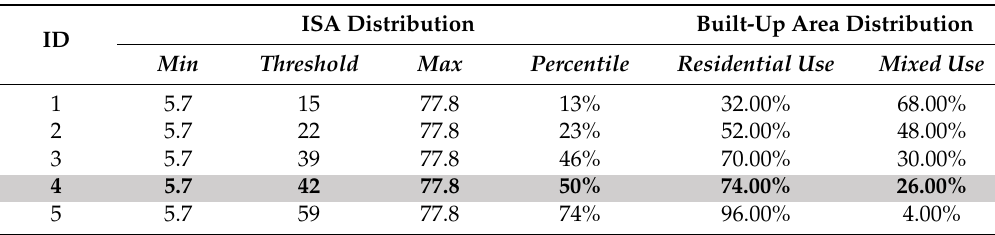
Table 1. ISA distribution thresholds and corresponding building use distribution ratios (grey indicating selected best-matching